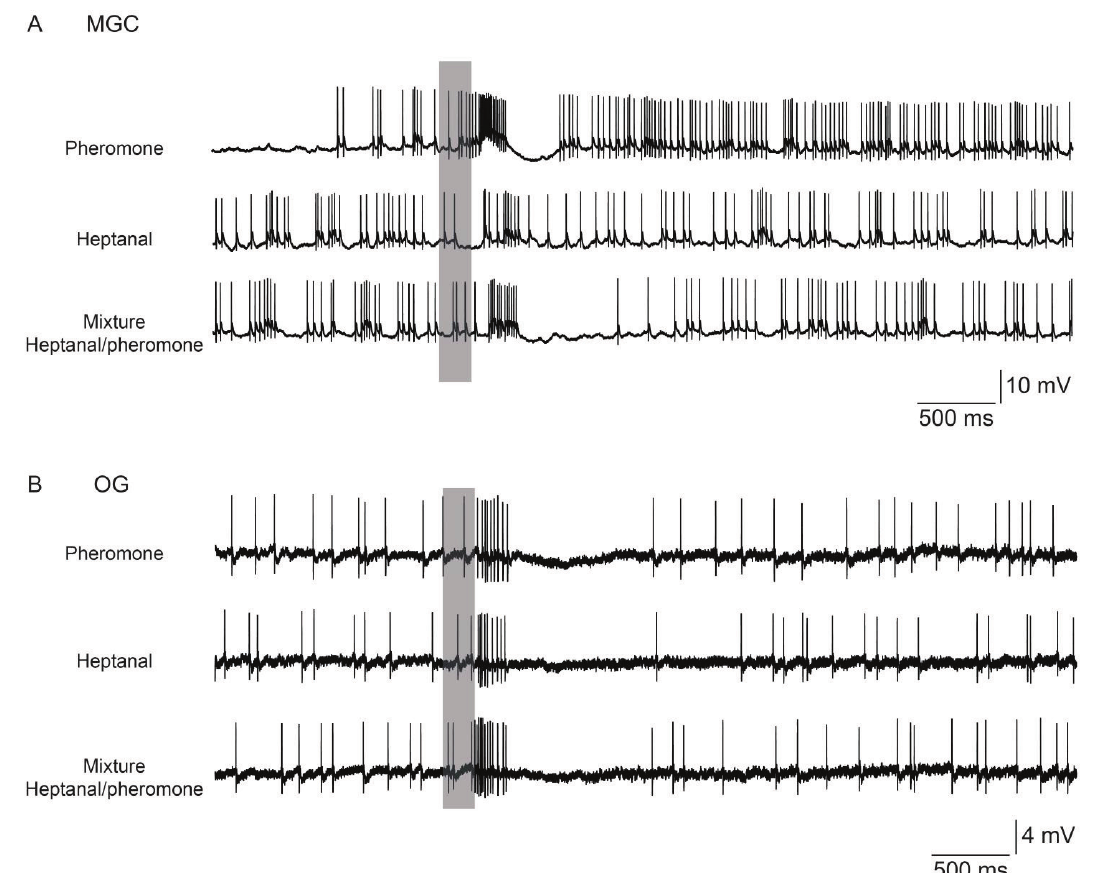
Figure 4. Interactions between pheromone and heptanal induce opposite effects in the response of neurons of the two sub-systems of the antennal lobe in Agrotis ipsilon . The different traces show examples of antennal lobe neuron responses to three olfactory stimulations (grey bar) ( i.e. , 1 ng of the sex pheromone, 100 μg of heptanal and the mixture of pheromone and heptanal) recorded intracellularly. ( A ) In the pheromonal sub-system (MGC), the neuron shown responds to the pheromone (blend) with a strong excitation followed by an inhibition phase (upper trace) and no or a weak response to heptanal. The presentation of heptanal together with the pheromone induces a reduced response, showing a suppressive effect (lower trace). ( B ) In the non-pheromonal sub-system (OG), neuronal responses are stronger for stimulation with heptanal (middle trace) than with pheromone (blend, upper trace). The responses to heptanal are further enhanced when adding the pheromone showing an additive mixture effect (lower